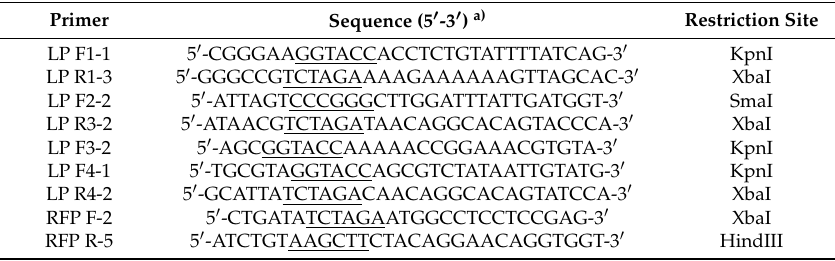
Table 2. Primers used for obtaining p R’ and rfp